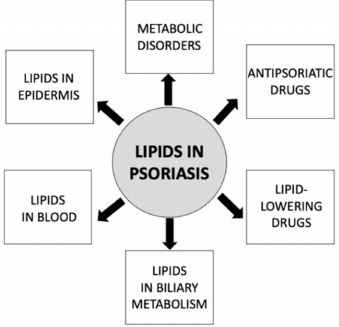
Figure 1. Multiple associations of lipids with different aspects of